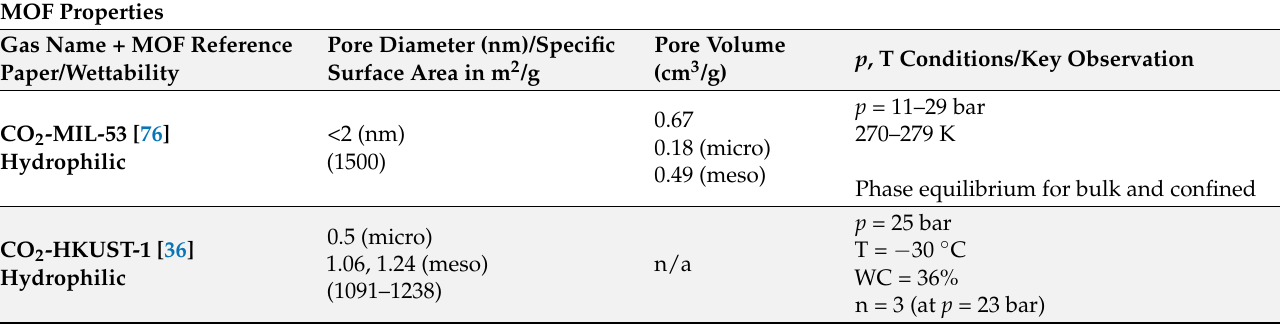
Table 3. Available research on MOF–hydrate Synergy for CO 2 storage (n/a = not available).